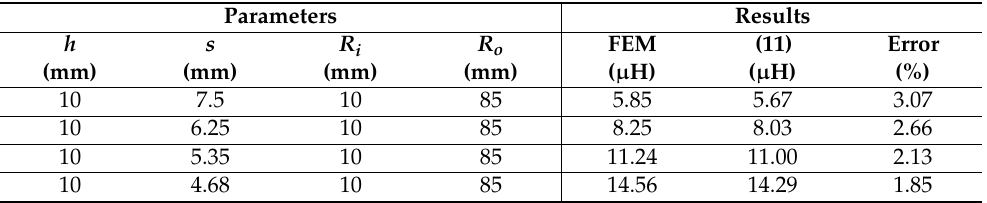
Table 1. Comparison result with variation in gap between the turn.